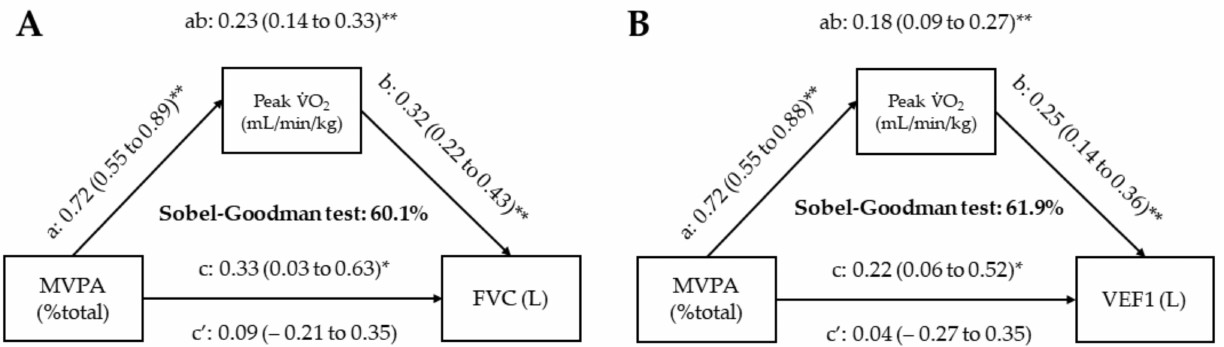
Figure 3. Cardiorespiratory fitness structural equation models of the relationships between moderate- to-vigorous physical activity and lung function, adjusted for age, sex, height, and cardiovascular risk score. ( A ) Results from mediation analysis with forced vital capacity as dependent variable. ( B ) Results from mediation analysis with forced expiratory volume in 1s as dependent variable. * p < 0.05; ** p < 0.01. FVC, forced vital capacity; FEV1, forced expiratory volume in 1 s; MVPA, moderate-to-vigorous physical